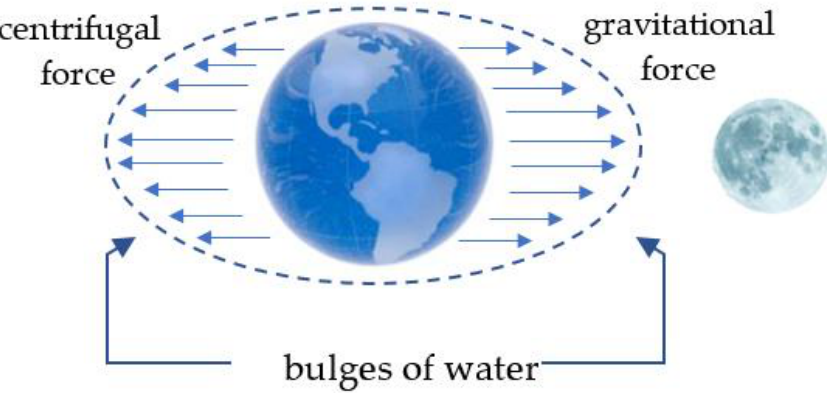
Figure 1. The influence of the moon on tidal genesis.